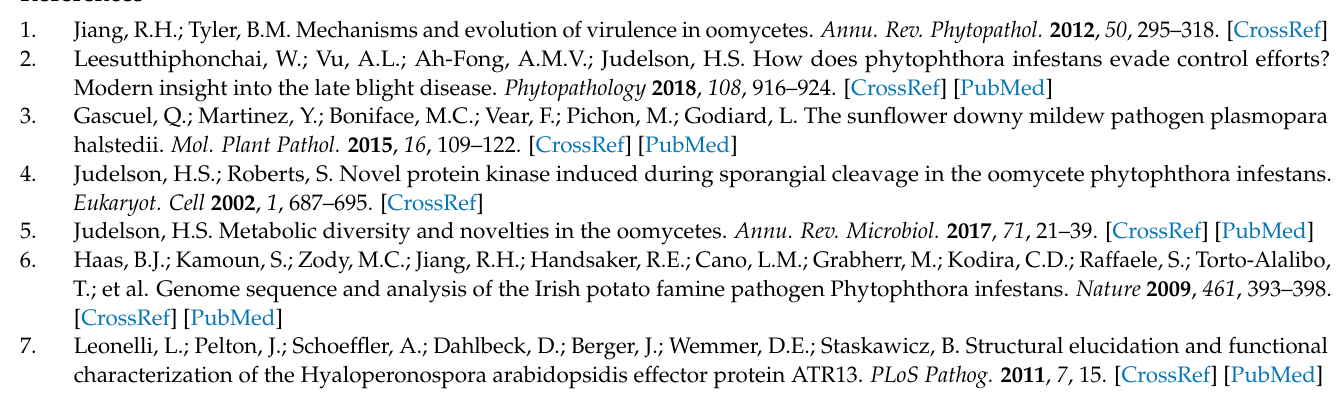
Figure S4: Barplot of KEGG annotation for the Ph. nicotianae genome, Figure S5: Phylogenetic tree for RXLR effectors in Ph. nicotianae , Figure S6: Conserved residues in the candidate CRN effector proteins in Ph. nicotianae , Figure S7: The predicted mechanism of Ph. nicotianae . Table S1: Genome accession numbers and gene names for all proteins included in this study, Table S2: KO annotations results of the Ph. nicotianae genome, Table S3: Elicitors in Ph. nicotianae and other species, Table S4: Syntenic regions comparison between Ph. nicotianae JM01 and Ph. nicotianae race 0, Table S5: Syntenic regions comparison between Ph. nicotianae JM01 and Ph. nicotianae race 1, Table S6: Syntenic regions comparison between Ph. nicotianae JM01 and Ph. nicotianae BL. Dataset 1: The Ph. nicotianae